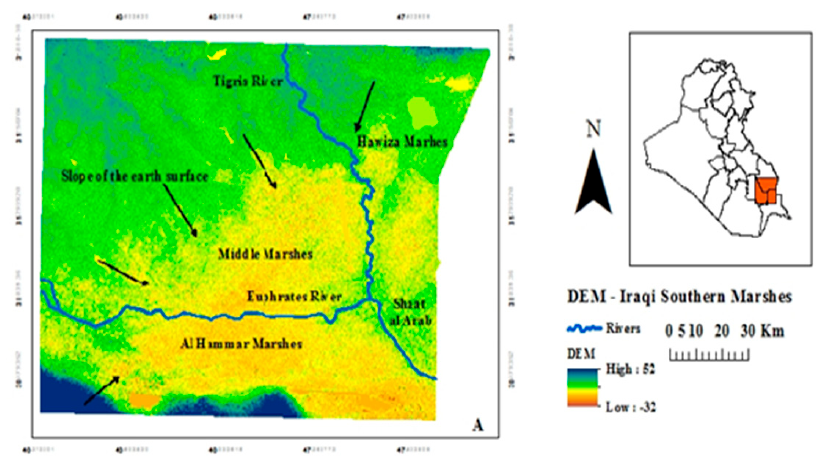
Figure 3. Digital elevation model (DEM) for marshes of southern Iraq.